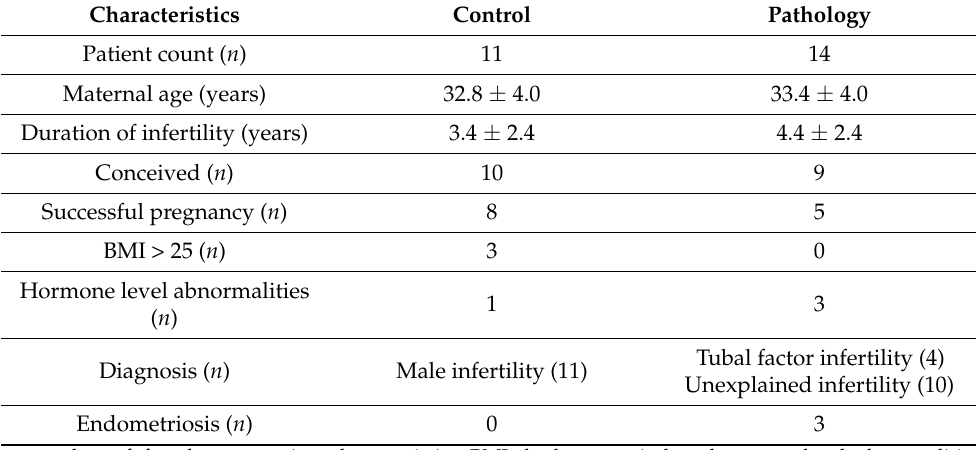
Table 1. Clinical characteristics of the study population.